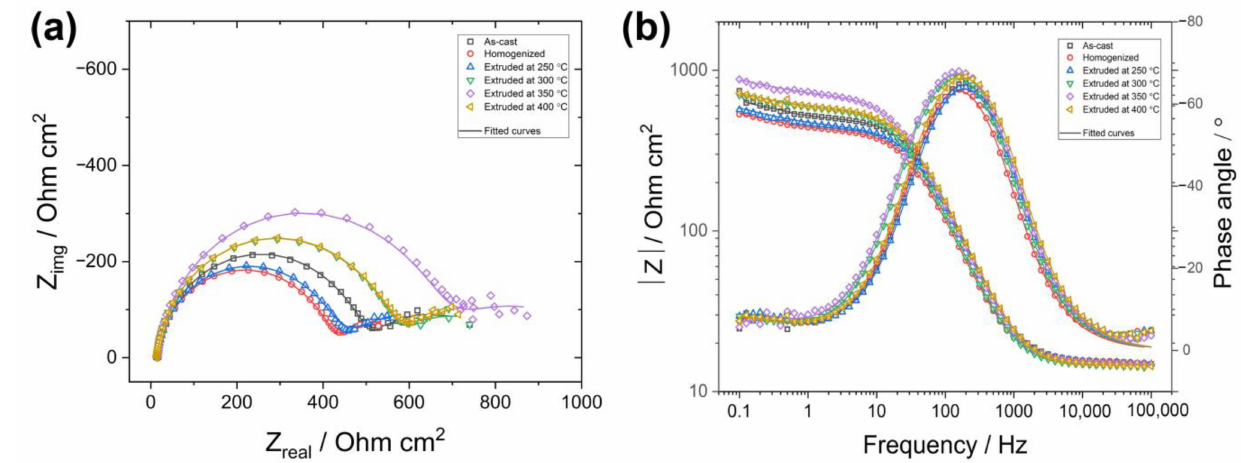
Figure 15. EIS curves: ( a ) Nyquist plots and ( b ) Bode plots.